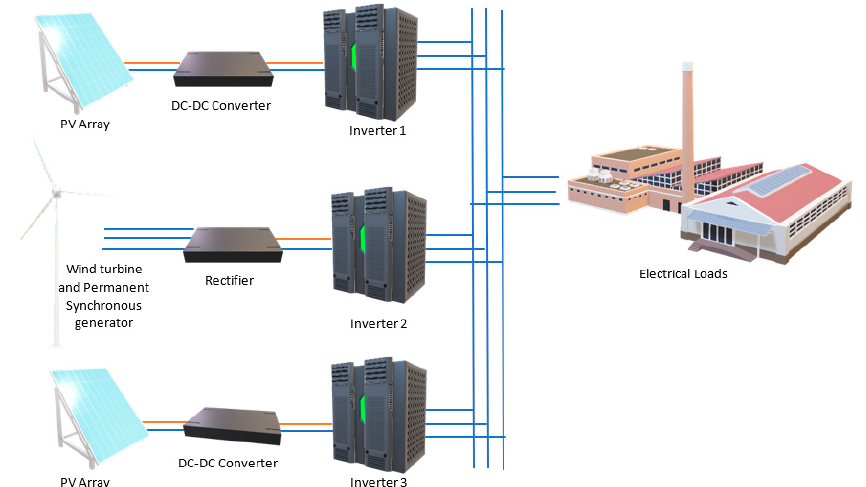
Figure 1. A hybrid microgrid with n-parallel inverters.